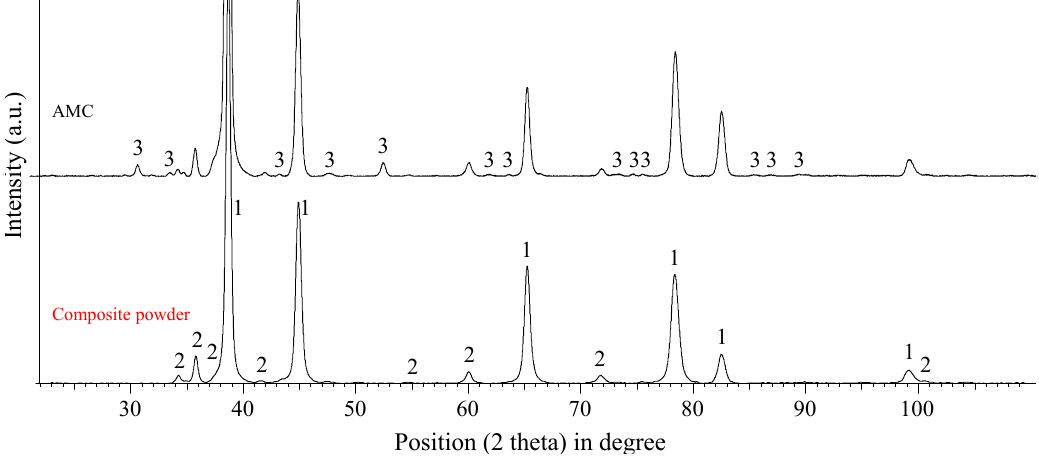
Figure 6. X-ray fine structure analysis of an AMC reinforced with 10 vol % SiC and 3 vol % boron and the underlying composite powder; matrix material: AA2017; size of the SiC and B particles: about 1 μ m; 1: Al, 2: SiC, 3: Al 3 BC.